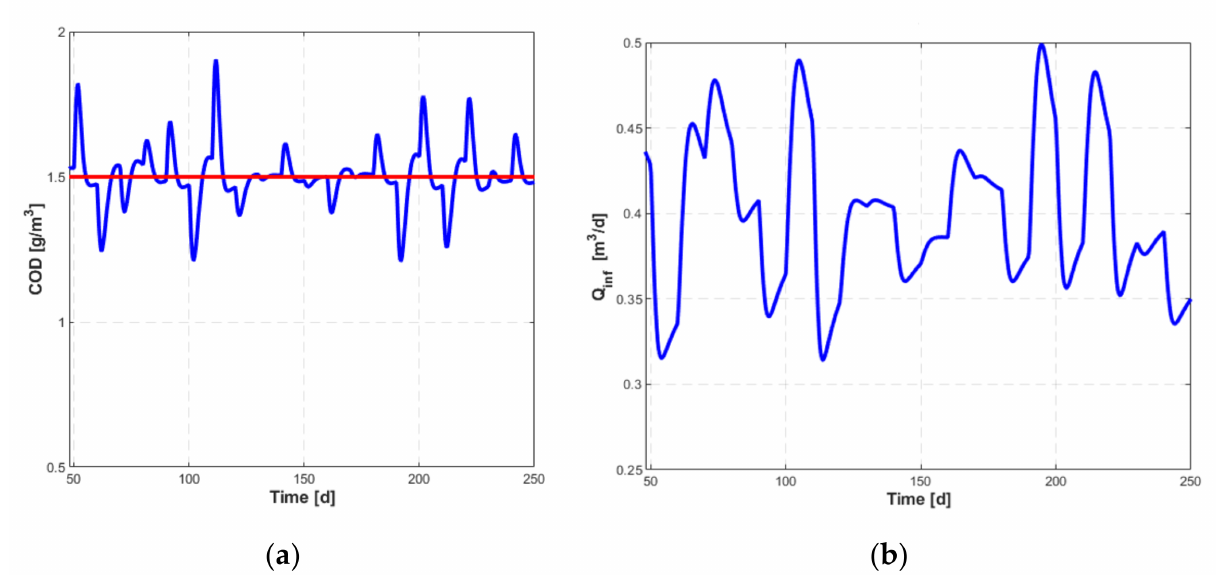
Figure 18. ( a ) The set point (red) and the controlled variable (blue); the command variable ( b